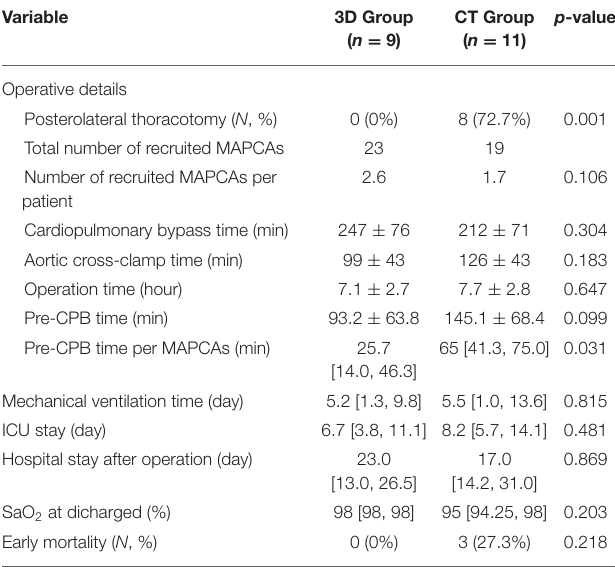
TABLE 2 | Operative details and early